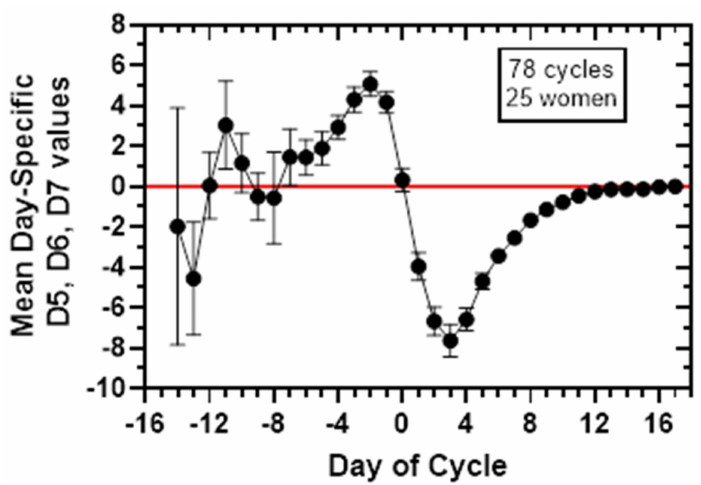
Figure 2. Mean day-specific Delta5, Delta6, Delta7 values taken together with 95% CIs for 78 cycles from 25 women. The day of the cycle is indexed to the day of putative ovulation, Day 0, the day after the urinary LH surge. The Delta value for a cycle on Day D, is the difference in the ratio E3G-AUC/PDG-AUC between day, D, and the preceding day, D-1, where E3G-AUC and PDG-AUC are the area under the curve for E3G and PDG, respectively, on a given day, D. Delta5 (D5), Delta6 (D6), Delta7 (D7) are the AUC computations beginning on calendar Day 6, Day 7 and Day 8 of a cycle, respectively. The mean day-specific values shown here used the D7, D6 and D5 values starting at calendar Day 9. These Delta values were used for the D5D6D7 convolution as described in the Section 2 and are provided in Supplementary Data, Table